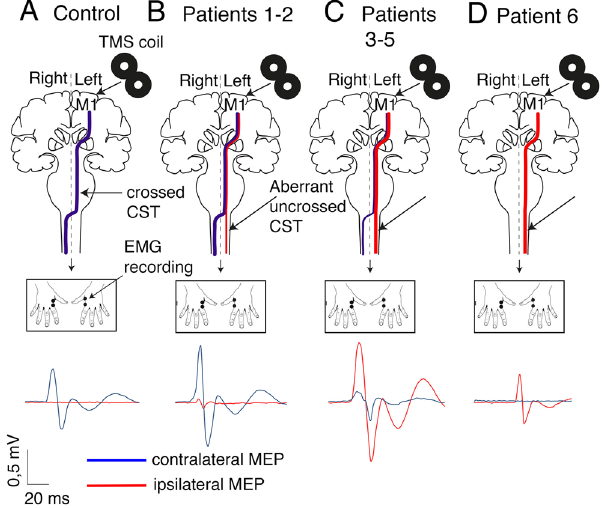
Figure 1. In healthy volunteers, unilateral stimulation of the hand area of the dominant primary motor cortex elicited only contralateral MEPs ( A , blue line, right hand), whereas ipsilateral MEPs were observed in the DCC patients ( B–D , red line, left hand). Depending on the patient, the ipsilateral MEPs were smaller ( B ) or larger ( C ) than the contralateral MEPs. In patient #6, stimulation of the dominant hemisphere elicited only ipsilateral MEPs ( D